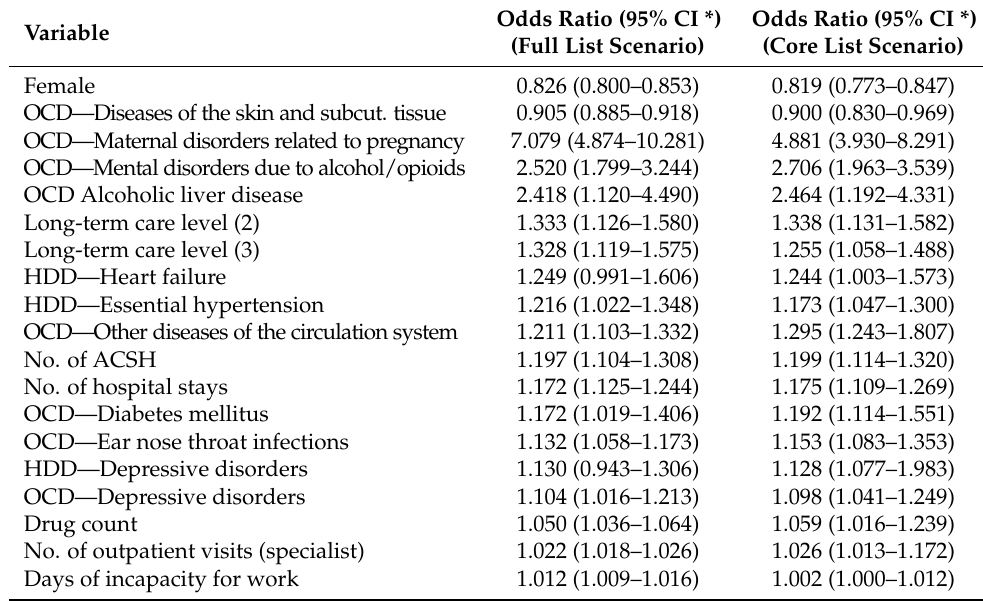
Table 3. Odds ratio of significant independent variables (except age classes) of the logistic regression models for predicting ACSH in the two scenarios.